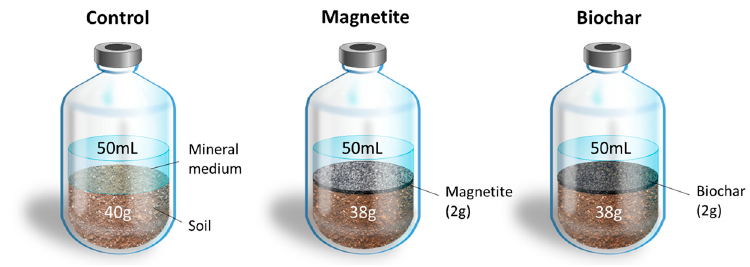
Figure 1. Sketch of the experimental setup.